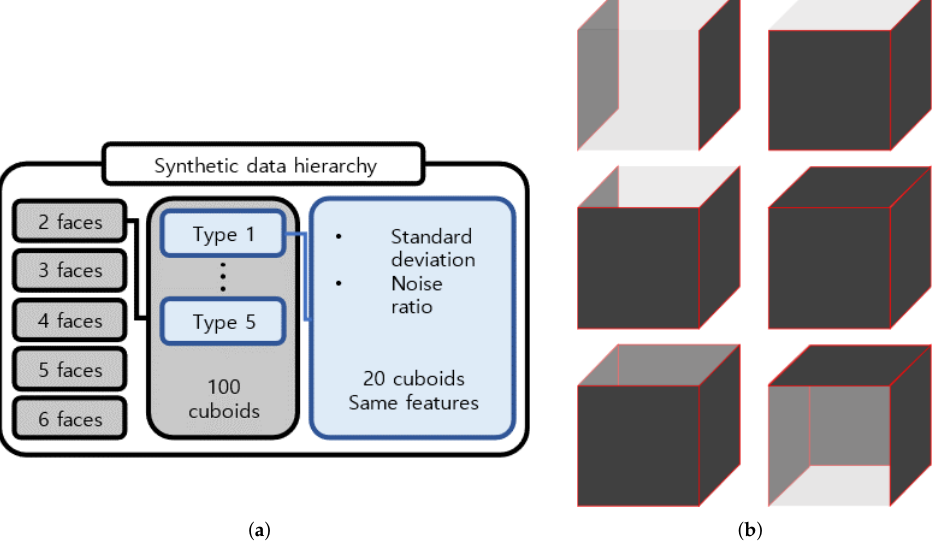
Figure 6. Synthetic data generation ( a ) Hierarchy of synthetic data. Total 500 synthetic cuboid point clouds are hierarchically generated as above. This figure illustrates the configuration of synthetic cuboid data containing two faces. Synthetic cuboid data with the same number of faces are composed of five types of cuboids. Each type of cuboid consists of 20 cuboids with same point deviations and point noise ratio that is randomly selected. Cuboids with different number of faces have same configurations. ( b ) Two types of cuboid models with same number of occluded faces. There are two combinations of cuboids with ( top row ) two faces, ( middle row ) three faces, and ( bottom row ) four faces, depending on their spatial relations. The dark face represents the surface where point clouds are